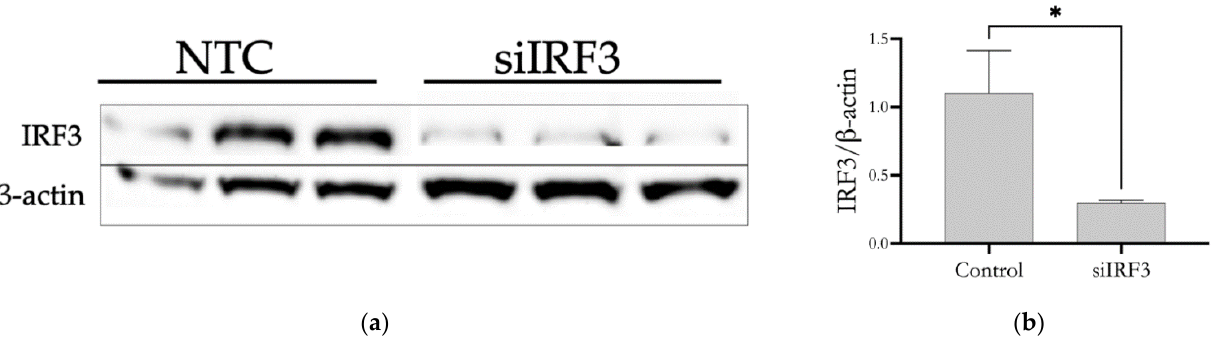
Figure 8. mRNA expression of IRF5 ( a ), ARG1 ( b ), EGR2 ( c ), NOS2 ( d ), IL-6 ( e ), and TNF- α ( f ) after IRF5 knockdown in macrophages treated according to protocol 2. Data are presented as mean ± SD, n = 3 [ns; not significant; **** p < 0.0001].